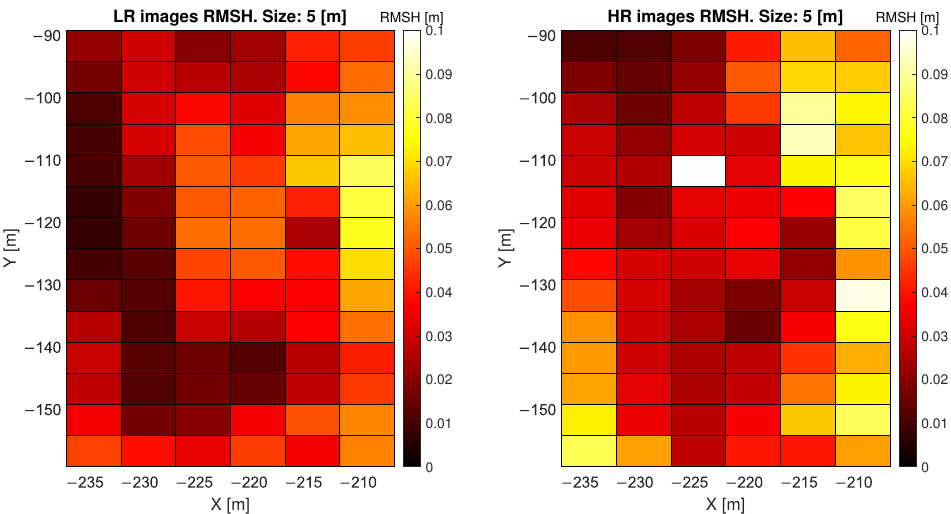
X [m] Figure 6. RMSH values evaluated for each pixel with 5m window size; comparison between HR and